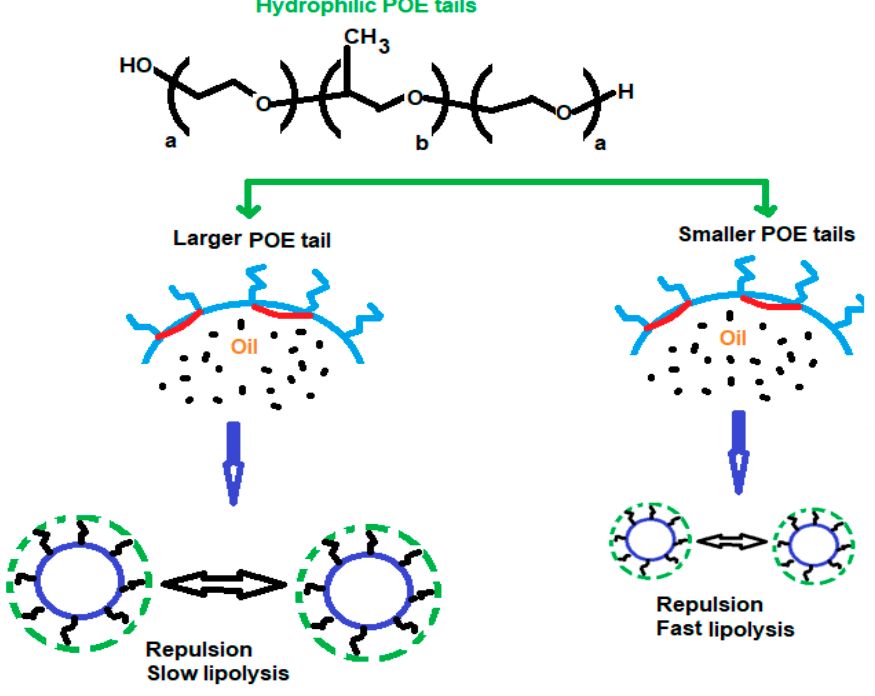
Figure 1. The influence of the poloxamer structure on the interfacial and macroscopic properties of nano-emulsions [35].